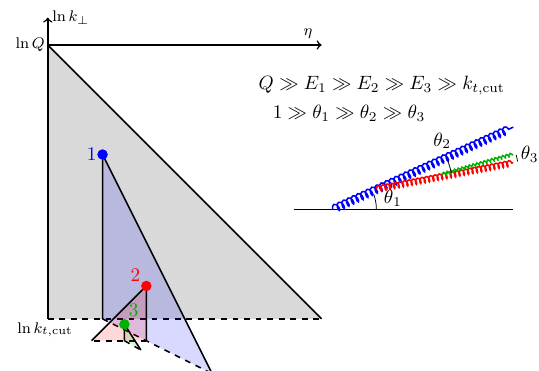
Figure 1. Representation of the nested gluon-emission pattern, strongly-ordered in both energies and angles, which constitutes the all-order DL